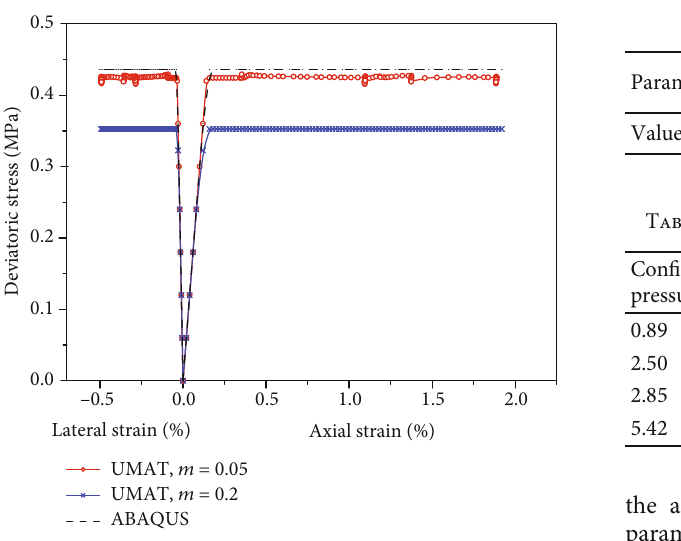
Figure 9: Stress-strain relation in uniaxial tensile cases. Table 1: Initial damage points under di ff erent con fi ning pressures.